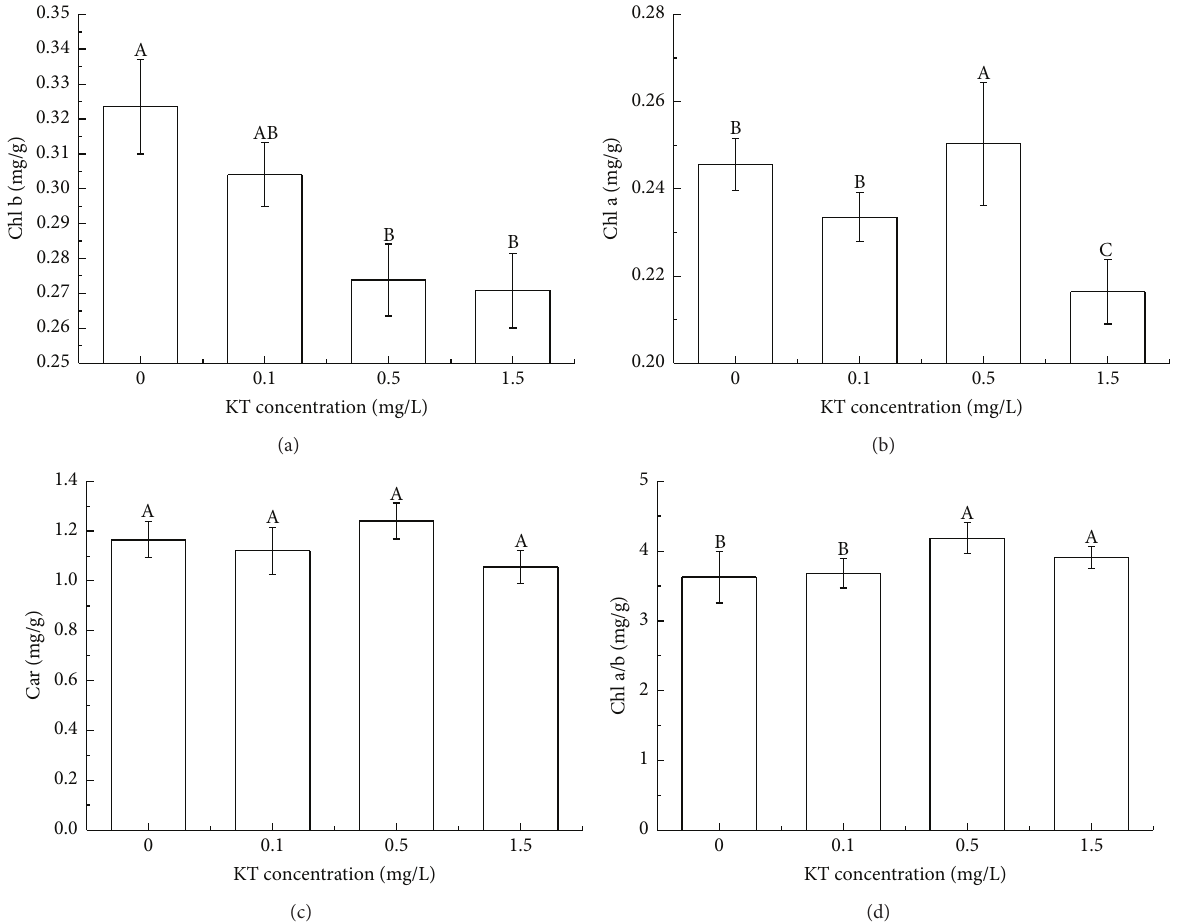
Figure 4: Effects of different concentrations of KT on the contents of photosynthetic pigments in maize seedlings under 0.5 mg/L arsenic stress. Values with different letters indicate a significant difference ( 𝑃 < 0.05